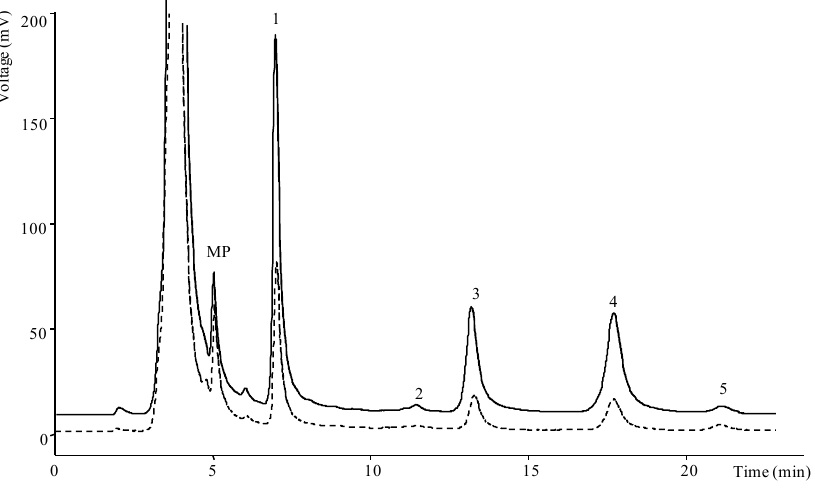
Figure 3. Chromatogram of tocopherols in blackberry